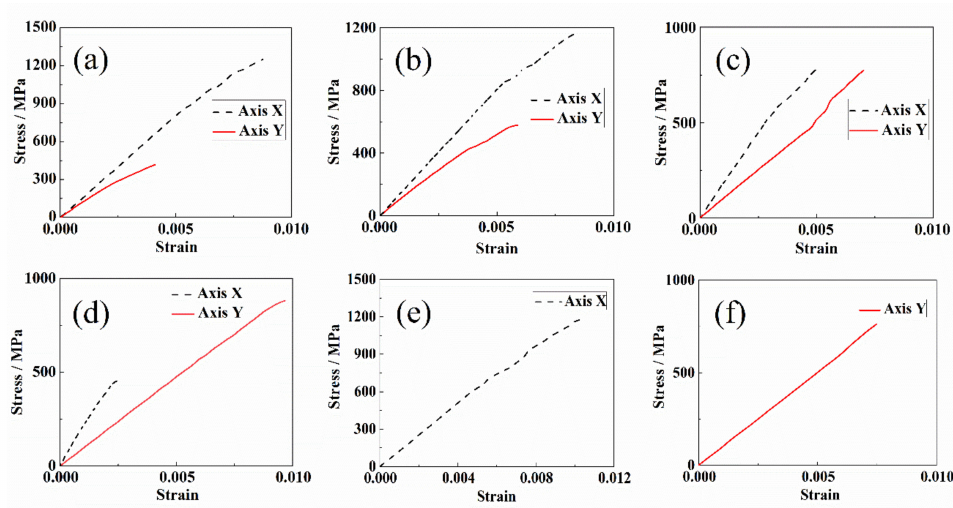
Figure 10. The stress–strain curves with loading ratio in X and Y direction by ( a ) 3:1, ( b ) 2:1, ( c ) 1:1,